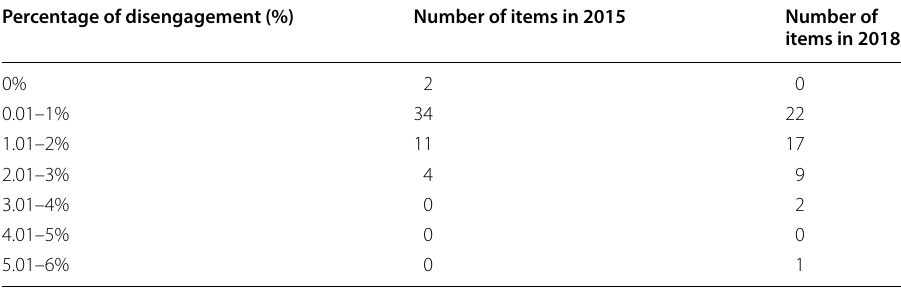
Table 3 Numbers of items by disengagement levels. Source : Organisation for Economic Co-operation and Development (OECD), Programme for International Student Assessment (PISA), 2015 and 2018 Mathematics Assessment Percentage of disengagement (%)